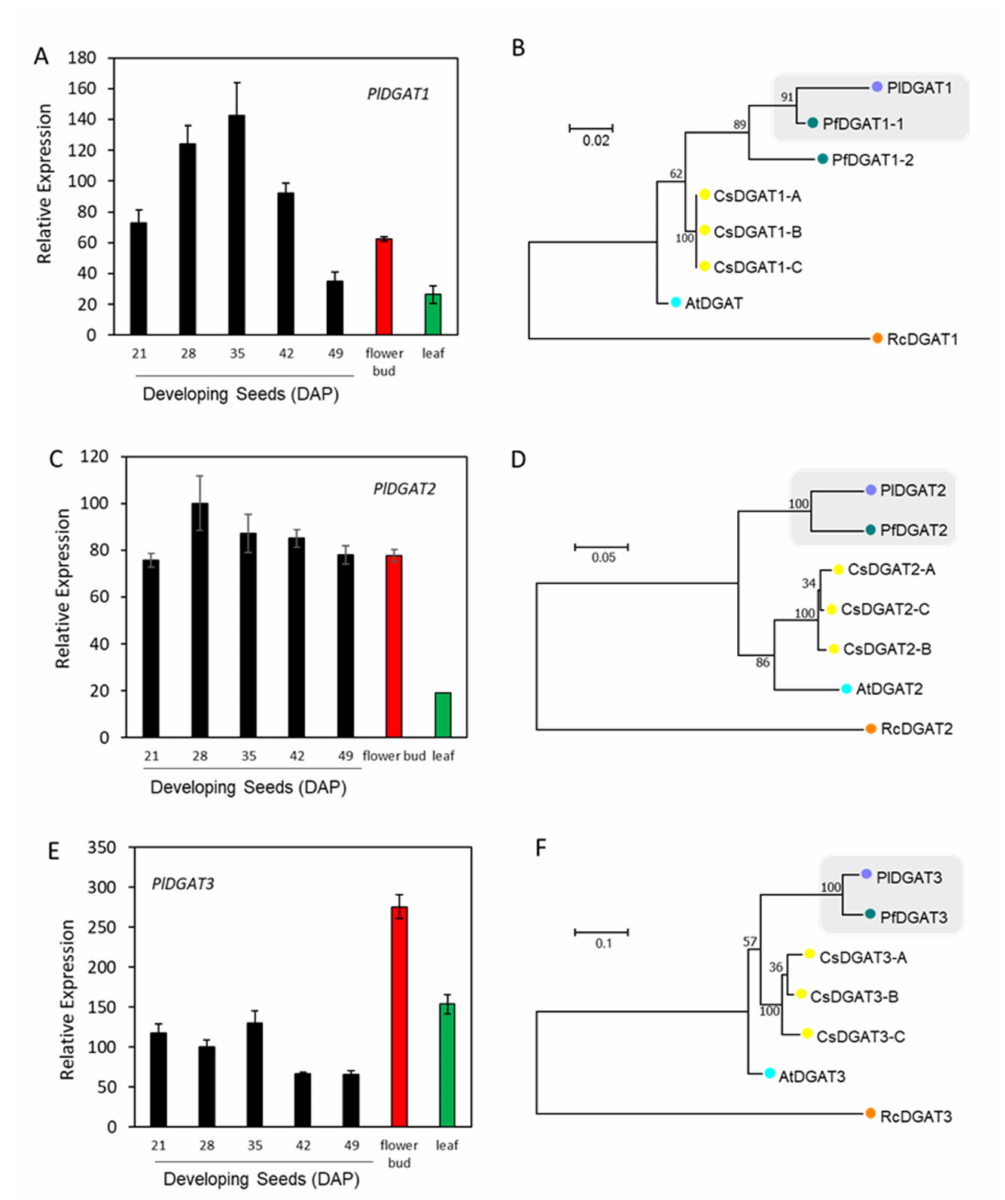
Figure 9. DGATs expression profiles and phylogenic trees. Relative expression level of PlDGAT1 ( A ), PlDGAT2 ( C ), and PlDGA3 ( E ) in the developing seed, flower, and leaf tissue by qRT-PCR. DAP; day after pollination. Phylogenetic tree of proteins for DGAT1 ( B ), DGAT2 ( D ) and DGAT3 ( F ) from Physaria lindheimeri (Pl), Physaria fendleri (Pf), Arabidopsis thaliana (At), Camelina sativa (Cs) and Ricinus communis (Rc). Pl and Pf genes are highlighted with a grey background. Genbank accession numbers are listed in Supplementary File 6, Tables